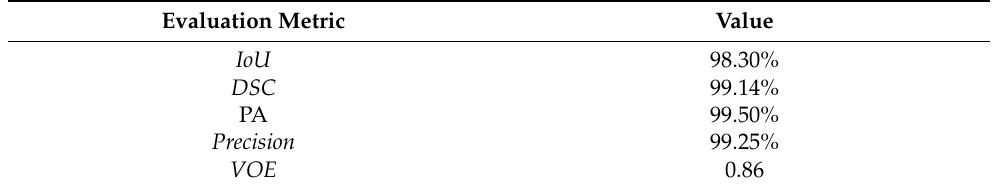
Table 4. Image segmentation confusion matrix. Table 4. The evaluation metric of image segmentation.